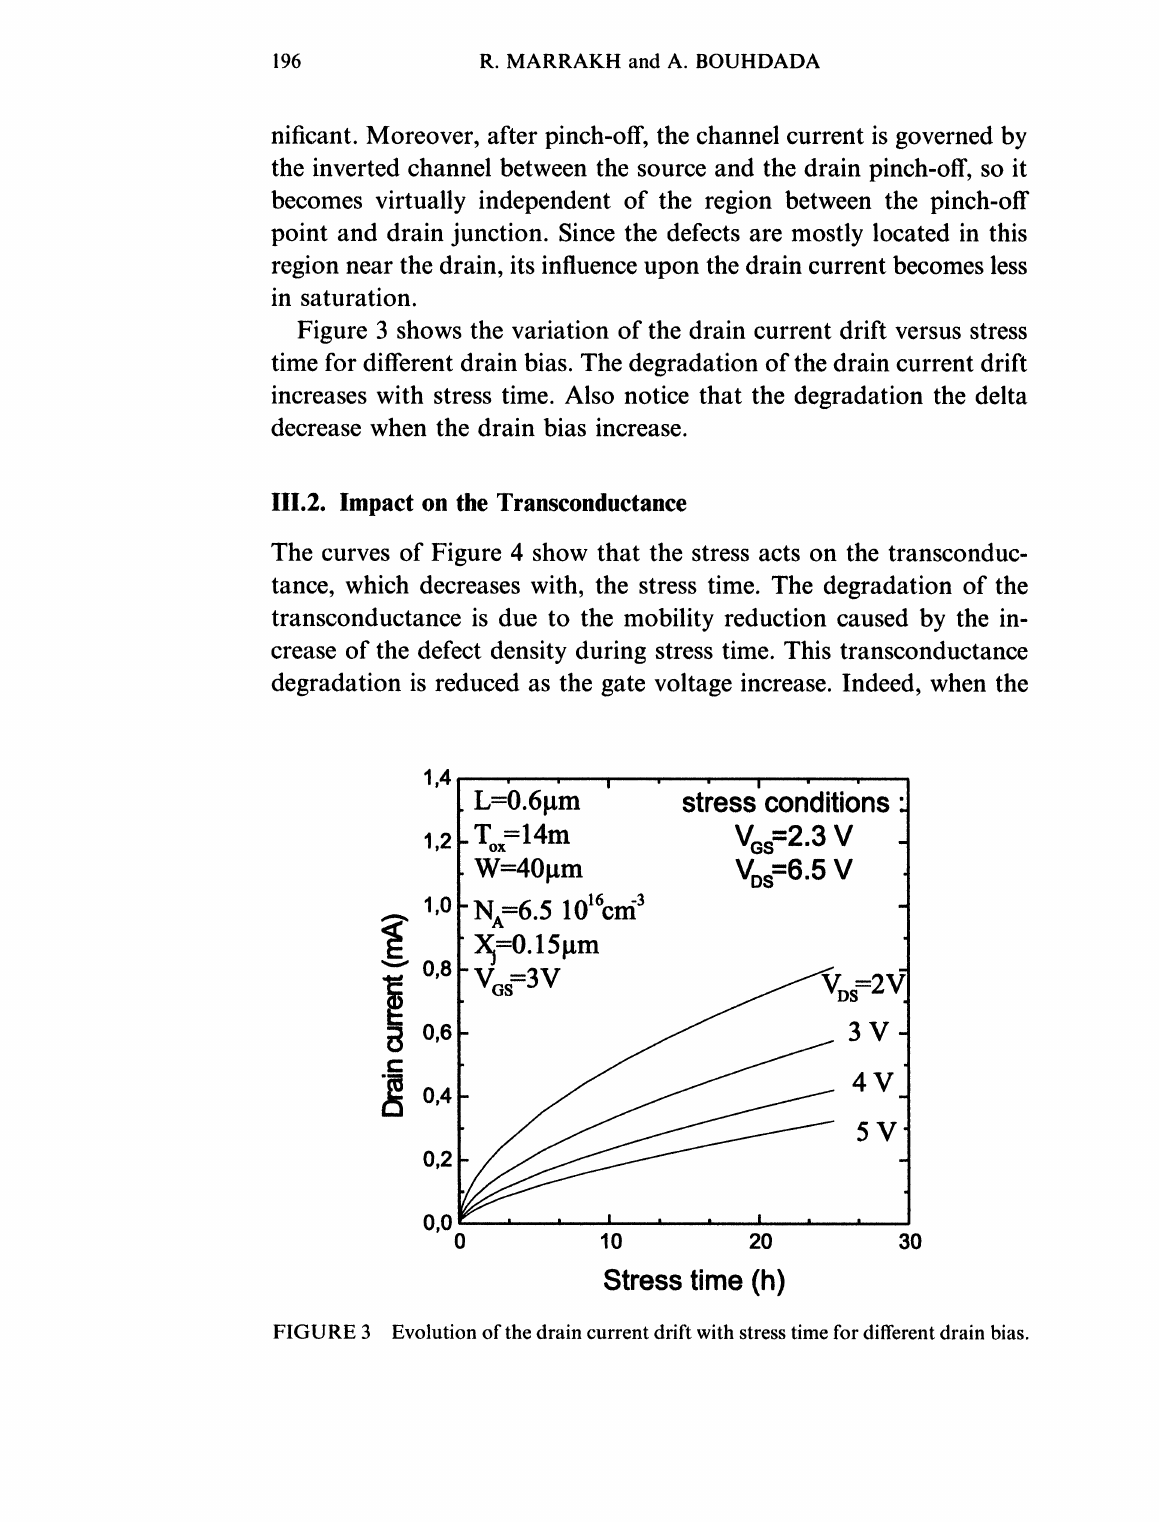
FIGURE 3 Evolution of the drain current drift with stress time for different drain